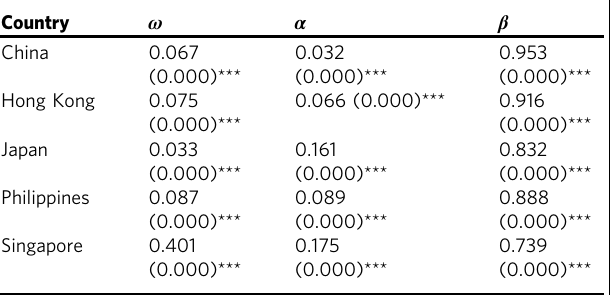
Table 4 Univariate GARCH model estimates.